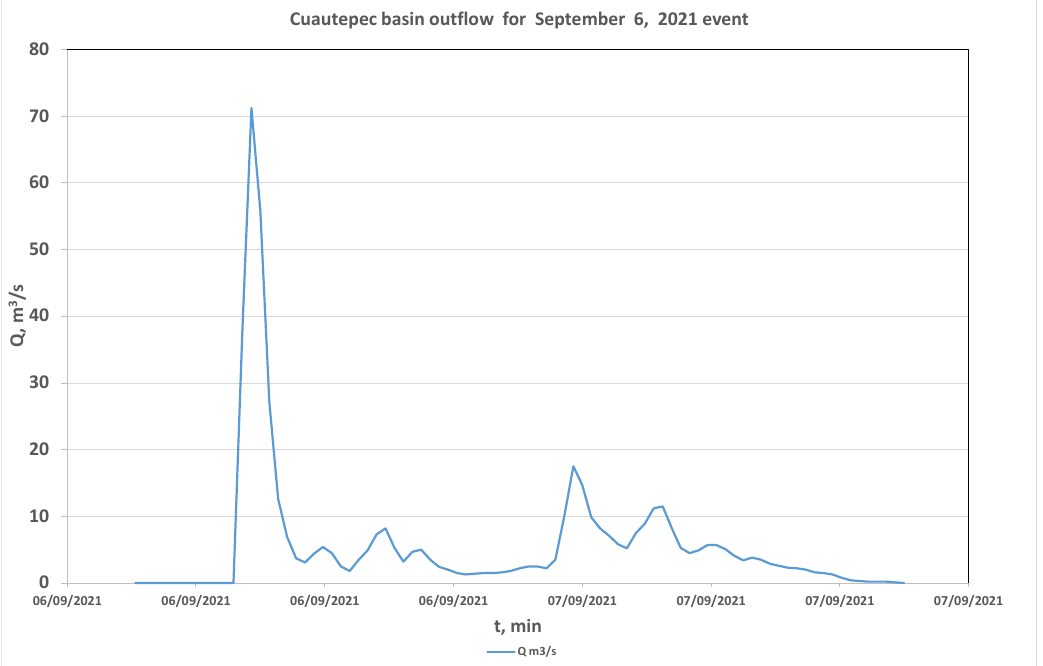
Figure 9. Estimated hydrographs for storms with different Tr and historical flash flood. 3.4. Depth and Velocity Maps of Historic Flash Flood When using Iber software using the historical hydrograph produced by the flash flood obtained with Hec Hms and a calculation time of 24 h, depth and velocity maps created using a calculation time of 13,600 s (3.78 h) are presented in Figure 10; these result were partially due to the high calculation time required by the Iber software to perform processing.